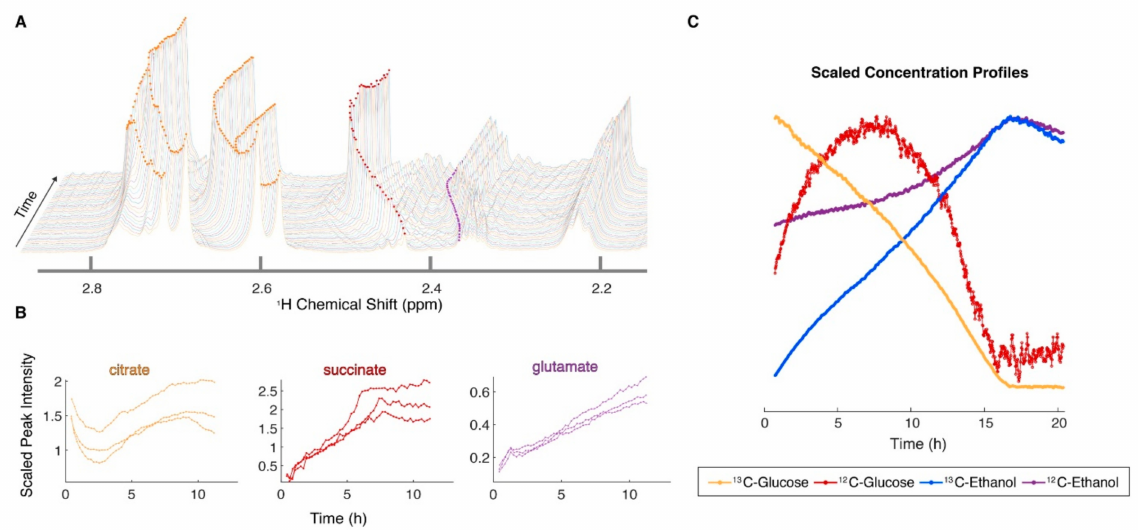
Figure 1. Continuous in vivo metabolism by NMR can be used to monitor the real-time growth of a microorganism under different environmental conditions. The data in ( A ) are from the filamentous fungus Neurospora crassa , growing in a high-resolution magic angle spinning probe at 600 MHz for about 12 h [10]. Oxygen can be introduced through a hole drilled into the cap of the NMR rotor [77]. The organism is alive at the end of the NMR experiment. The selected ridges shown in ( B ) were from 3 replicates and can be extracted from the NMR data using a computer vision algorithm [78] and plotted as a function of time. Isotopic substrates can also be used in this experiment ( C ), which allows for tracing of different pools of metabolites, as described more completely in Judge et al. [10]. Reprinted with permission from Ref. [10]. Copyright 2021 American Chemical